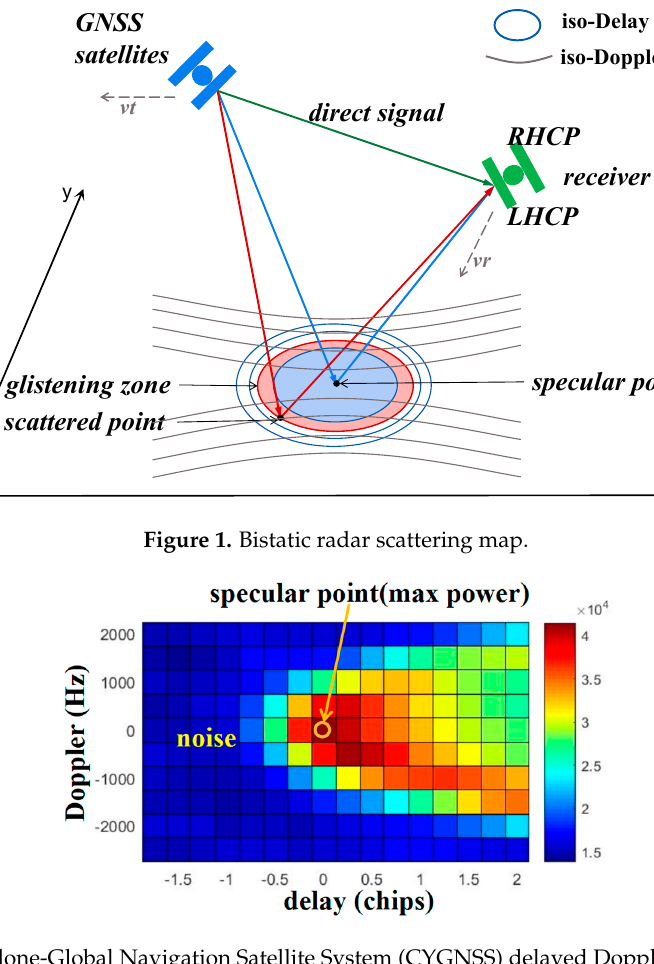
Figure 2. Cyclone-Global Navigation Satellite System (CYGNSS) delayed Doppler map (DDM).